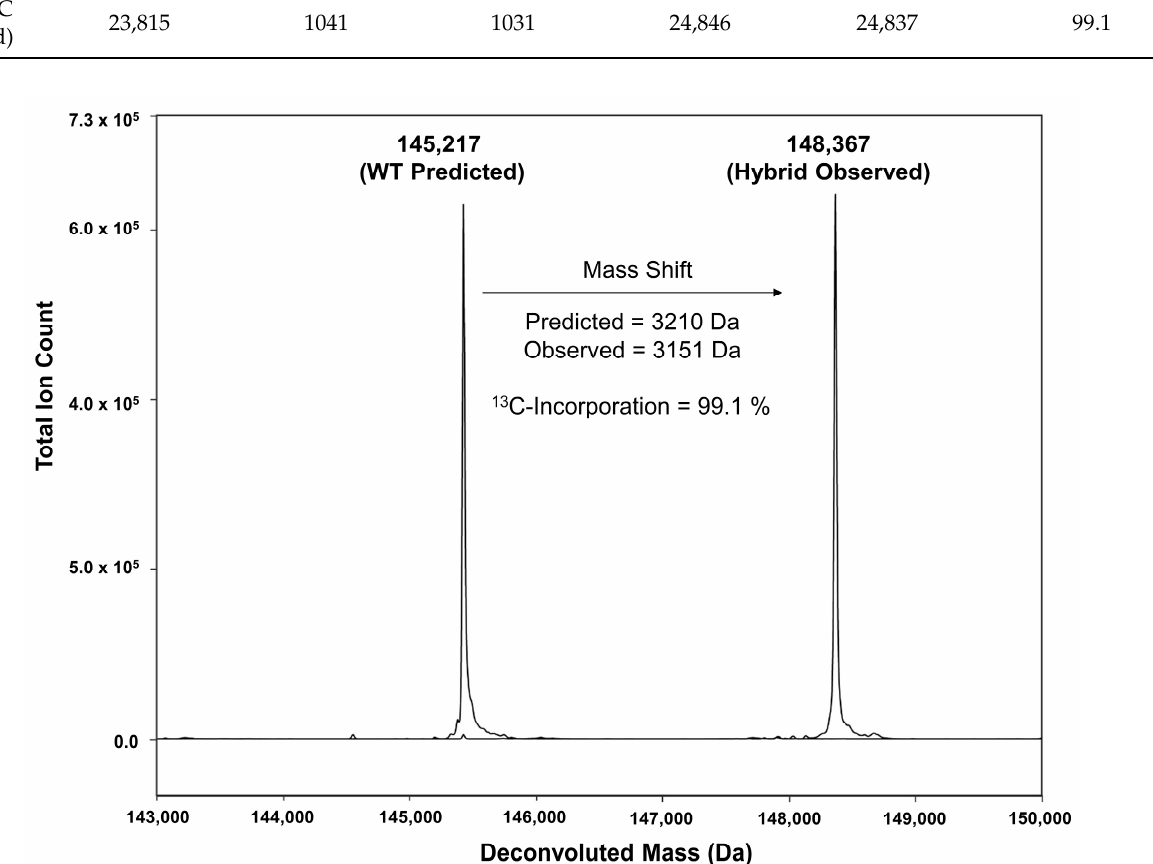
Figure 3. Intact mass analysis of the hybrid molecule ( right side ) compared to the predicted WT molecule ( left side ).